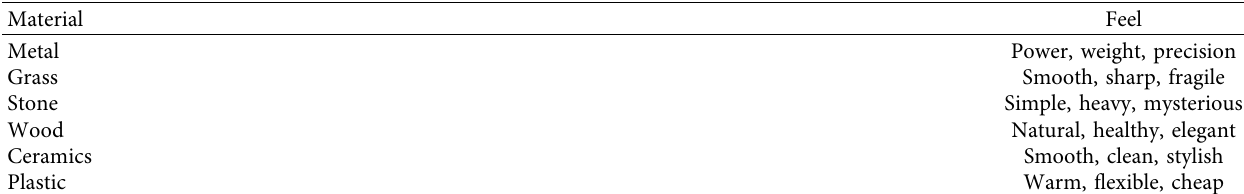
Table 3: Emotional expression of different